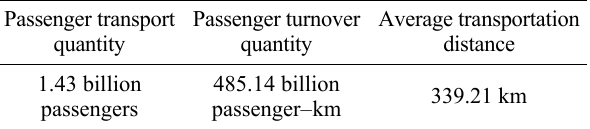
Table 3. Based on the two parameters, the average transportation distance can then be calculated. Table 3 Travelling parameters of CRH in 2020.